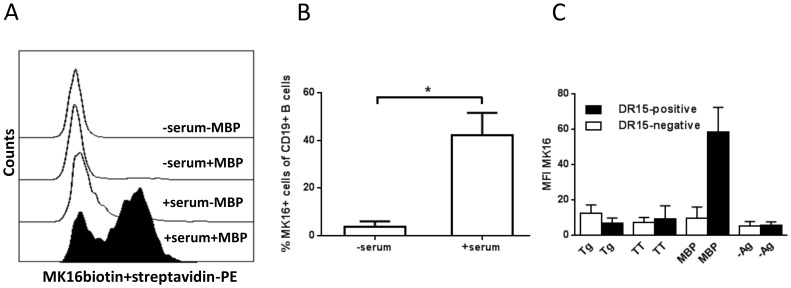
Presentation of MBP85-99 by HLA-DR15+ B cells.PBMCs from HLA-DR15+ individuals were incubated with MBP (whole protein) in the presence or absence of normal serum (30% v/v) for 18 h. Biotinylated mAb MK16 and streptavidin-PE were used as markers of MBP85-99 presentation. A) Representative histogram plot of 5 healthy donors showing binding of MK16 to live (7AAD-negative) B cells in the absence or presence of serum and MPB. B) The percentages of MK16-positive live B cells in 5 healthy HLA-DR15+ donors are shown; background values (no MBP added) have been subtracted. C) MK16 staining of B cells incubated with 30 µg/ml thyroglobulin (Tg), tetanus toxoid (TT), myelin basic protein (MBP) or no antigen (-Ag) in 4 healthy HLA-DR15+ donors (black bars) and 4 healthy HLA-DR15/16 negative donors (white bars). Means and SEM are shown. *p<0.05.